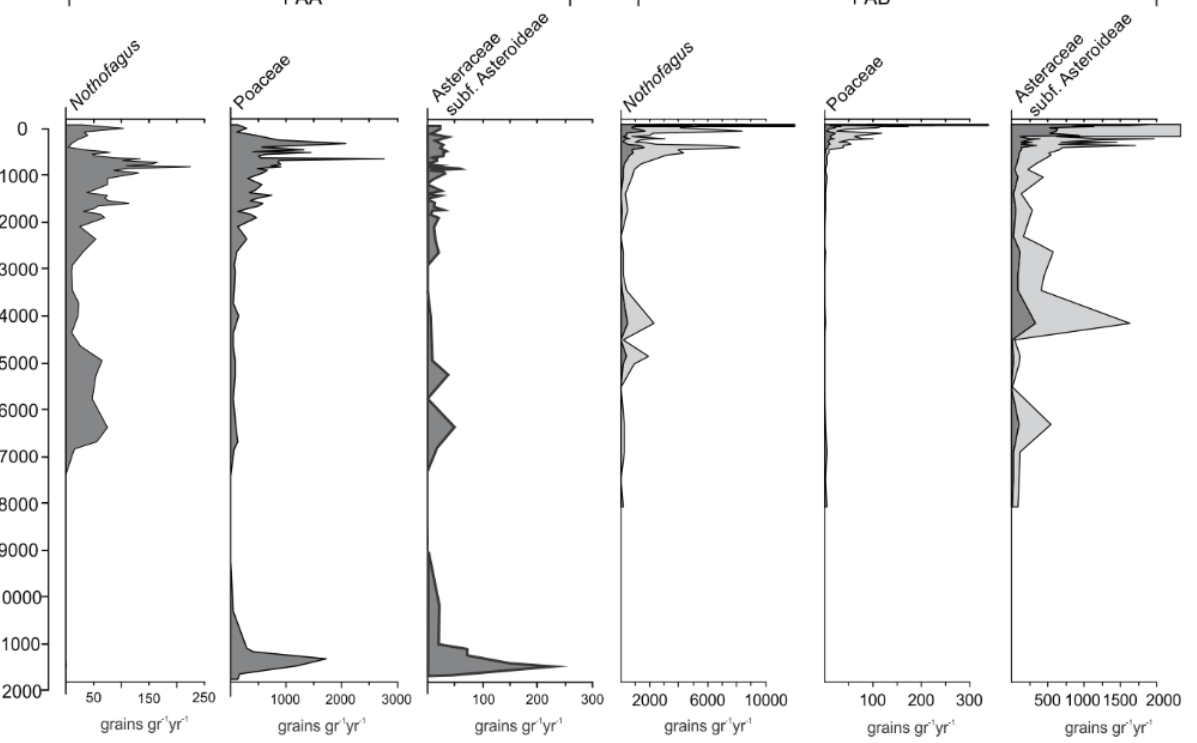
Figure 8. Pollen Accumulation Rate (PAR; dark grey shading) diagram for selected pollen types from Península Avellaneda Alto and Bajo. Light grey shading shows 5× exaggerations of the same